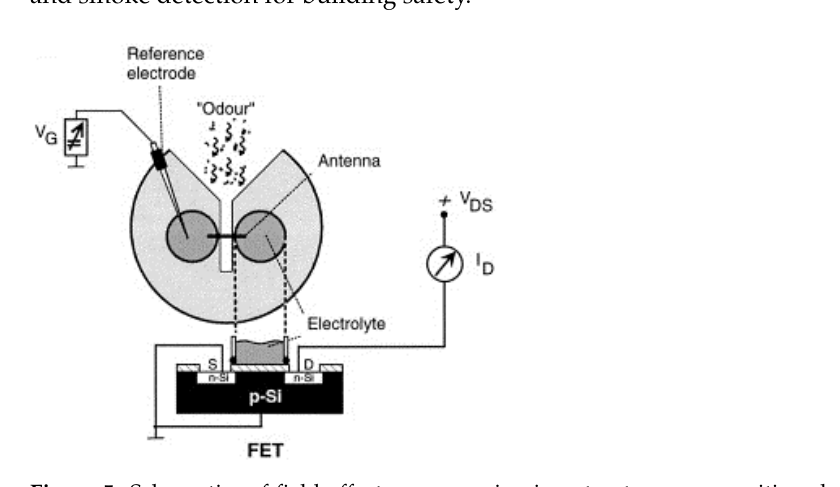
Figure 5. Schematics of field-effect sensors using insect antenna as sensitive element and FET as transducer for volatile marker detection towards plant protection. (Reprinted with permission from ref. [20]. Copyright 2000 Elsevier).